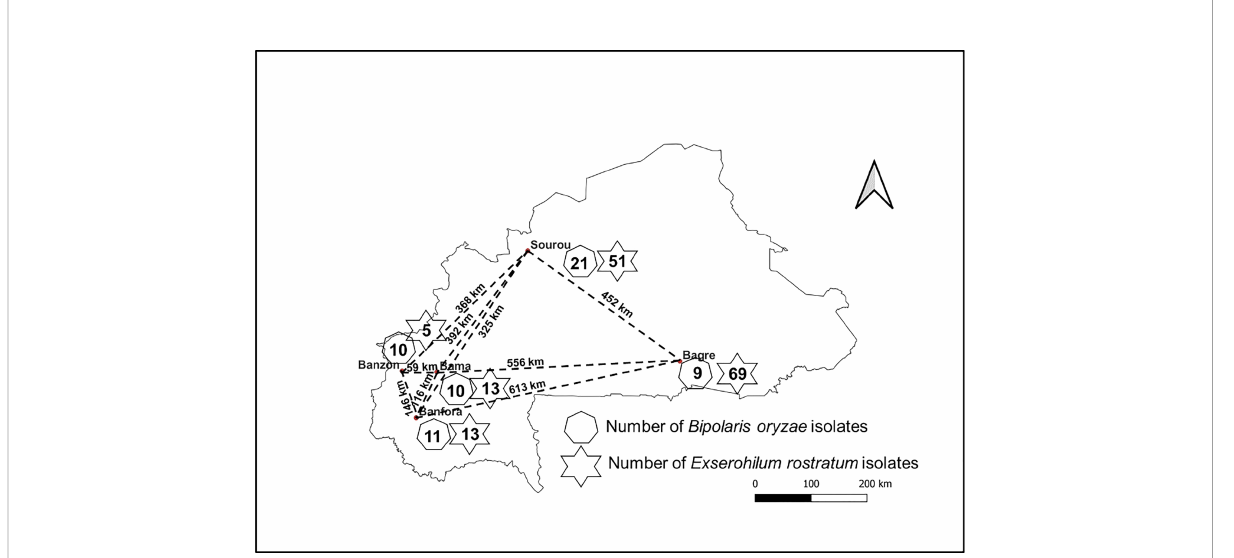
FIGURE 1 Schematic location of collection sites for infected rice samples. The number of Bipolaris oryzae and Exserohilum rostratum isolates isolated is indicated by the heptagons and stars respectively. Names in bold refer to the localities where samples were collected and the dashed lines indicate the distance between collection